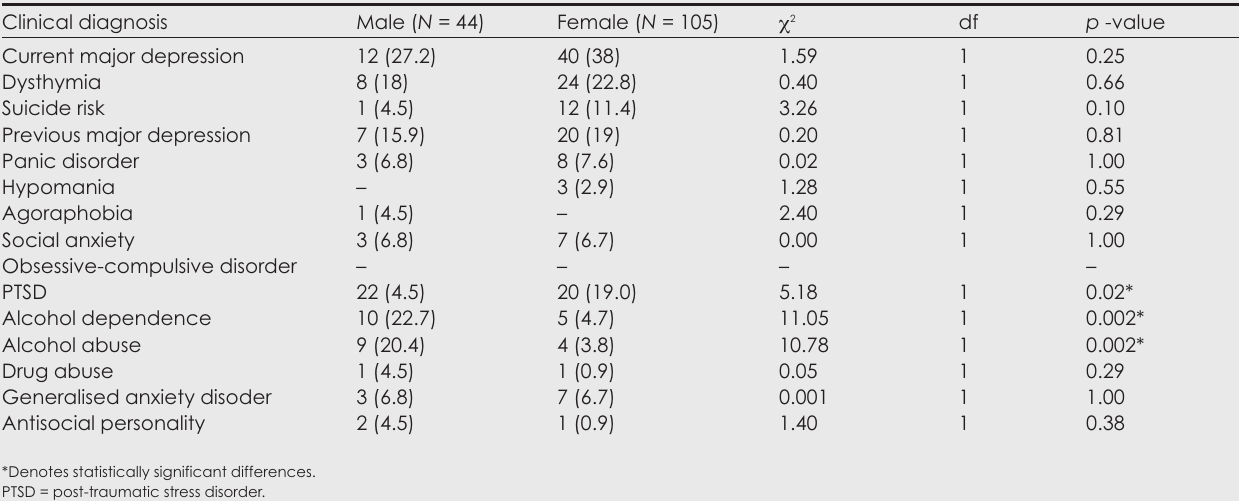
Table I. Gender differences in psychiatric morbidity of HIV/AIDS patients ( N (%)) Clinical